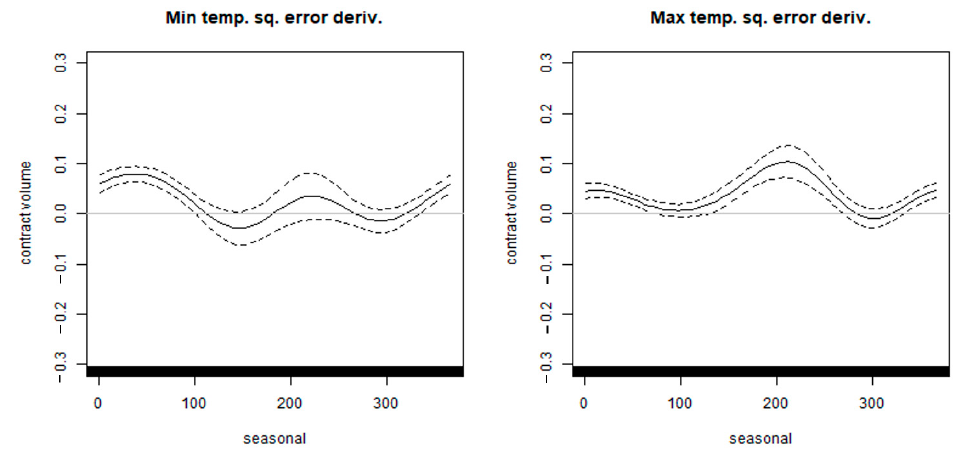
Figure 7. Estimated contract volume of the temperature squared error derivatives in the price model (13).